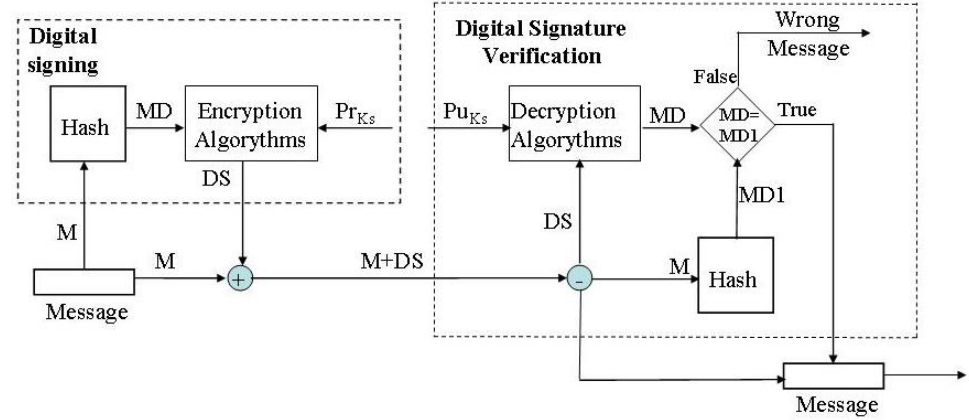
Figure 1. Digital signing and digital signature verification procedure.